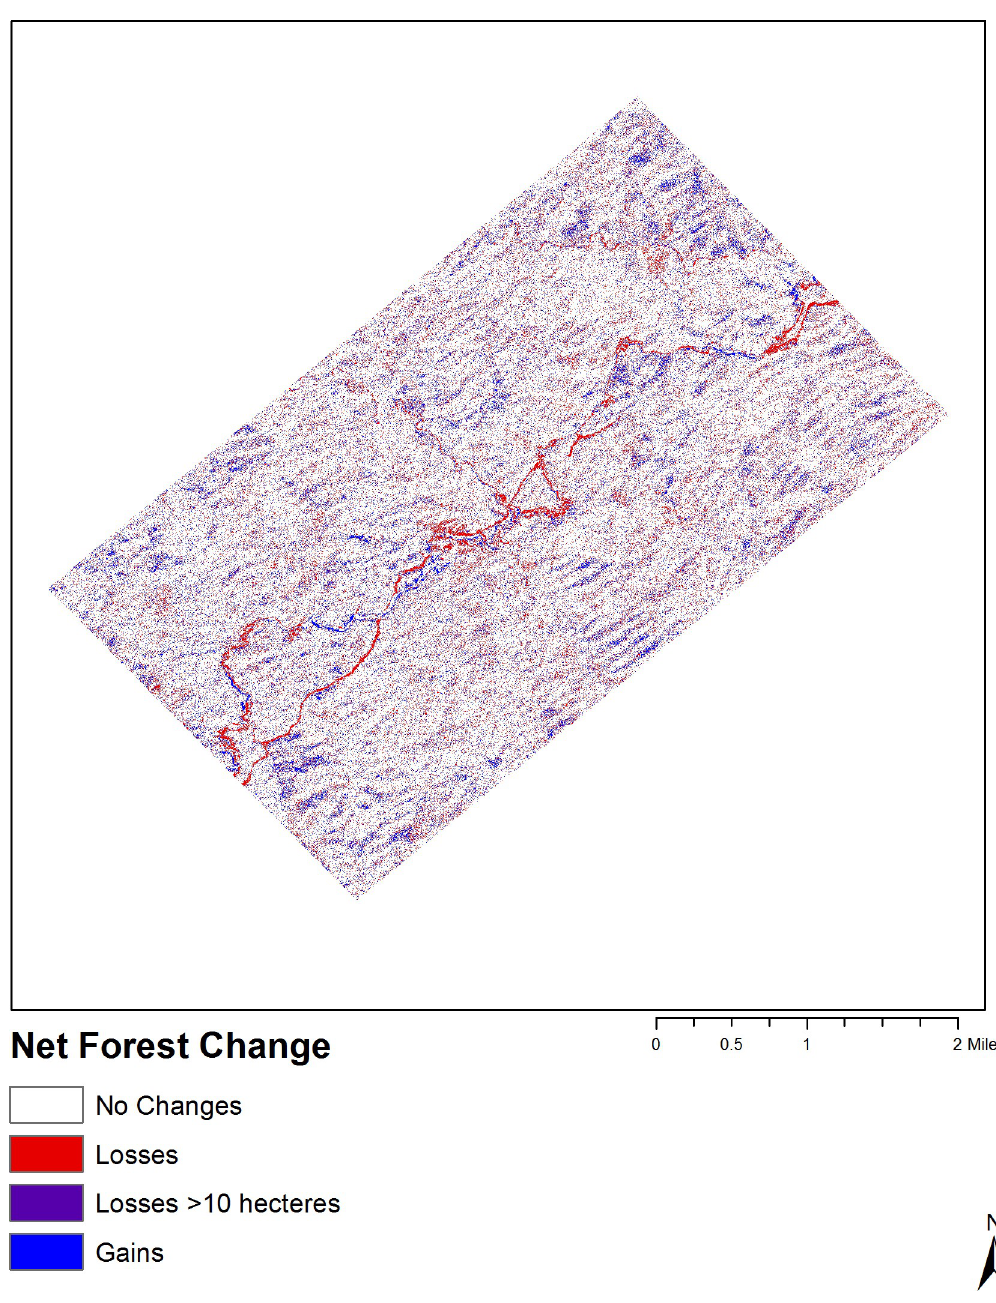
Fig 7. Net forest change between 2010 and